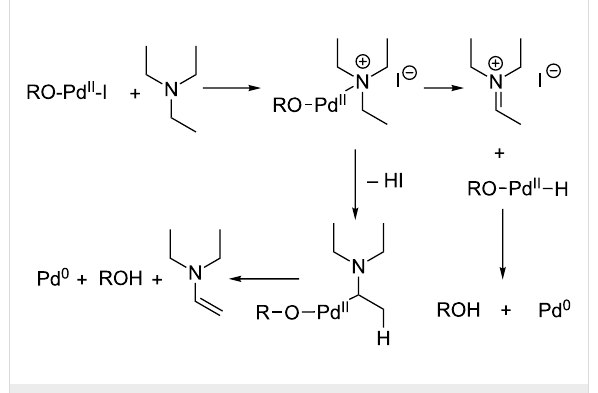
Scheme 10: Possible mechanism of the reduction of palladium(II) to palladium(0) by triethylamine (additional ligands at palladium are not depicted for clarity of the